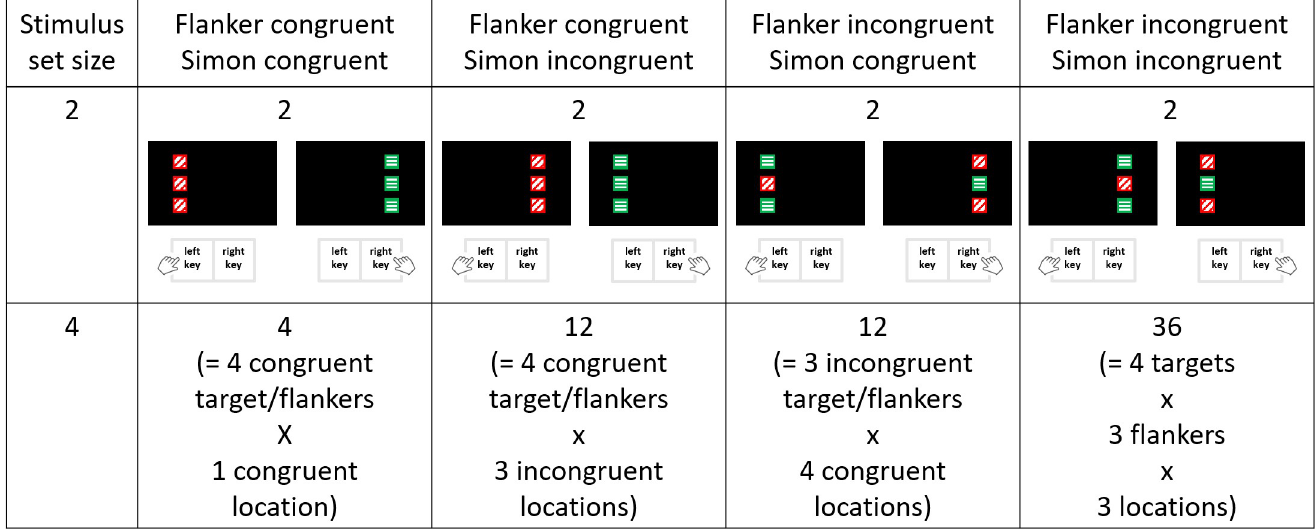
Fig 2. Number of stimulus-response pairings for each trial type (flanker congruent–Simon congruent, flanker congruent–Simon incongruent, flanker incongruent–Simon congruent, flanker incongruent–Simon incongruent) in set size 2 and 4. For the set size 2, the target feature associated to the correct response is the color of the central square, which was presented either in red or green. These two colors are additionally presented in oblique and horizontal striations, respectively. The red color was mapped to the left key, whereas the green color was mapped to the right key.